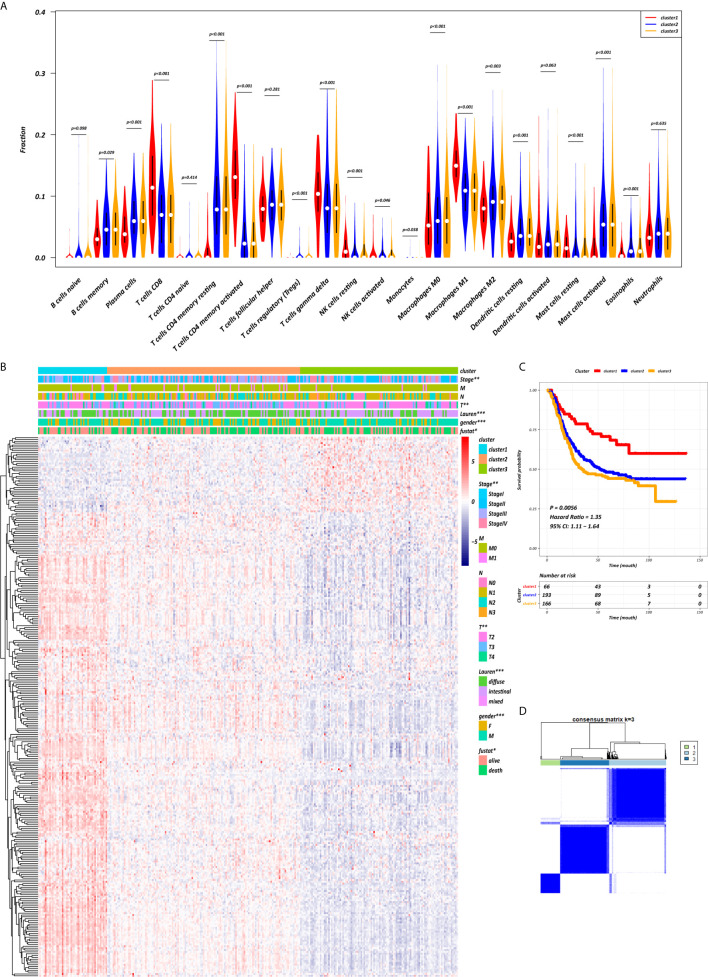
CD4+ MTRM-based clusters significantly associated with prognosis, clinicopathological characteristics and immunocytes. (A) Violin plot comparing immunocyte proportions between the three clusters. (B) Unsupervised hierarchical clustering of CD4+ MTRM gene subsets in patients with gastric cancer. (C) Kaplan-Meier analysis with log-rank test of the three clusters. (D) Consensus matrixes of GC samples in CD4+ MTRM.